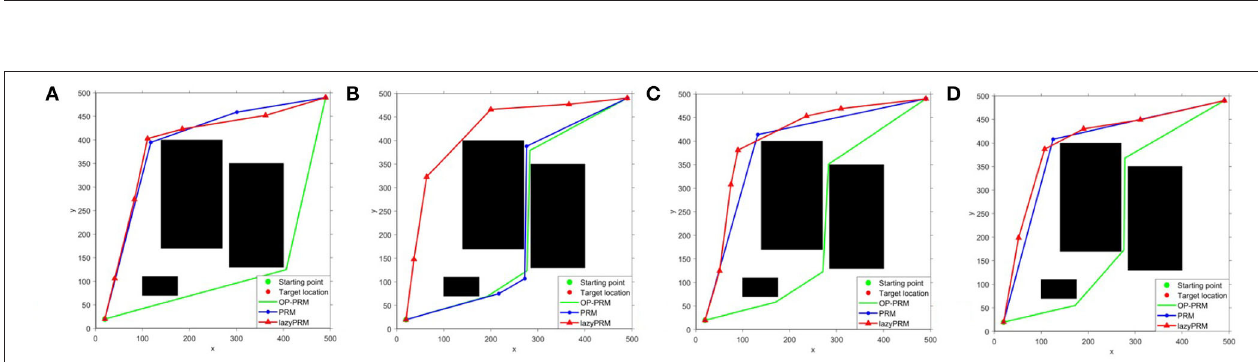
FIGURE 8 | (A–D) The experiments of dynamical obstacle